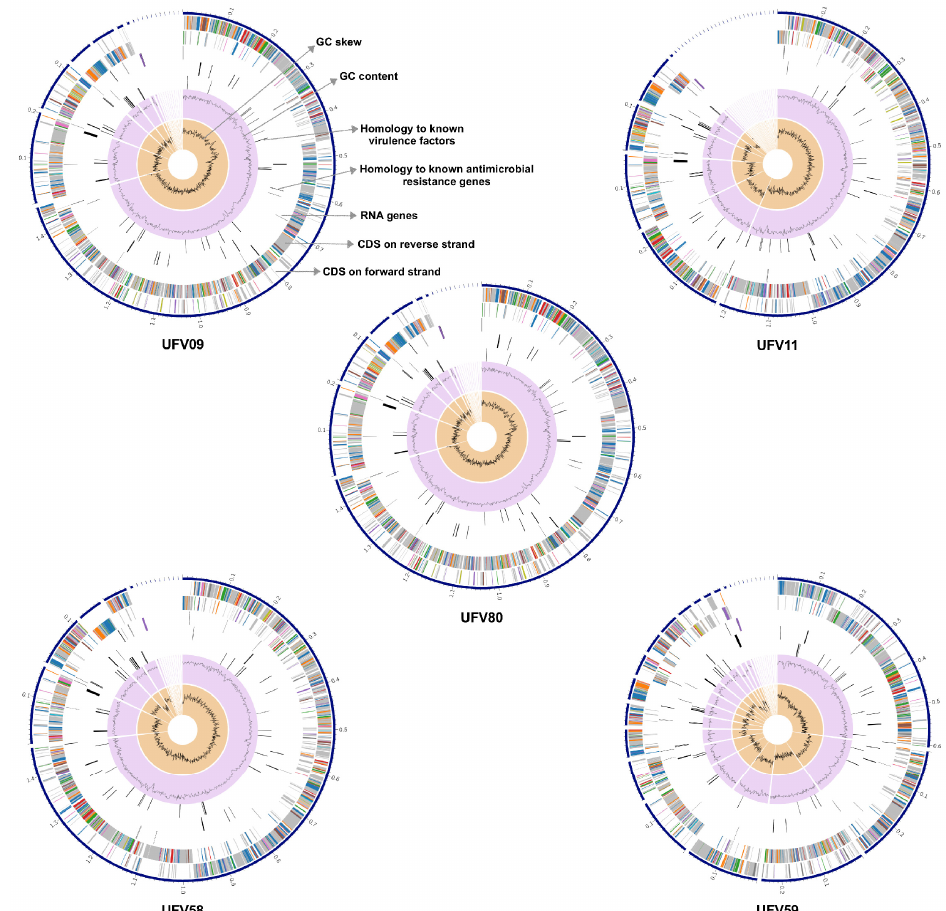
Figure 2. Circular genome maps of the ruminal Streptococcus lutetiensis strains displaying relevant genome features. The first (outermost) blue line shows the contigs; The second circle shows open reading frames oriented in the forward direction, whereas the third circle indicates those oriented in the reverse direction; the fourth circle shows the tRNA genes and the rRNA operons; The fifth and sixth circles show genes with homology to known antimicrobial resistance genes and known virulence factors, respectively; the seventh circle (purple background) shows the GC content (%) plot and the innermost circle (orange background) shows the GC skew. The colors of the open reading frames in the forward and reverse direction indicate the subsystem these genes belong to (see Subsystems details below). Empty spaces represent absence of sequence homology to each respective feature layer. The concentric circles showing different features of the S. lutetiensis genomes were generated using the Circos program.